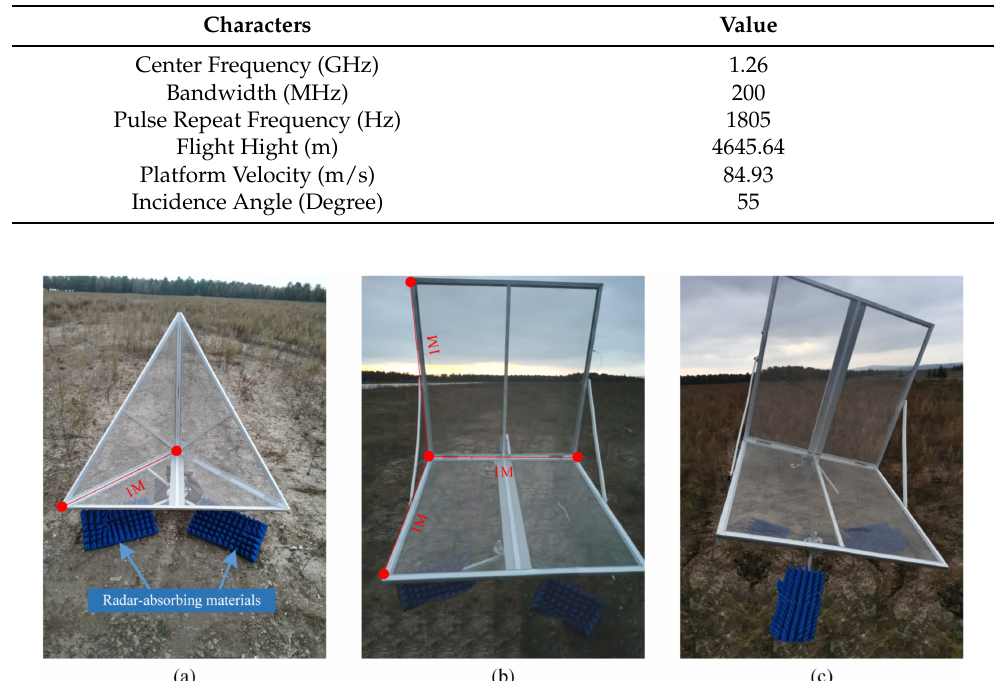
Table 1. LQP SAR system technical specifications.